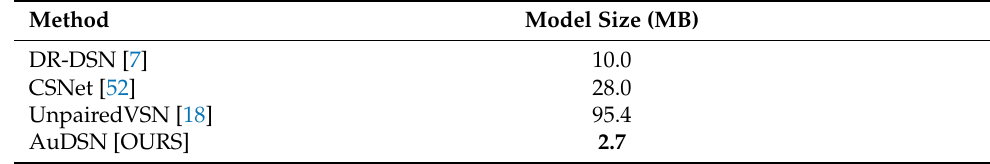
Table 5. Sizes of the parameters generated by different